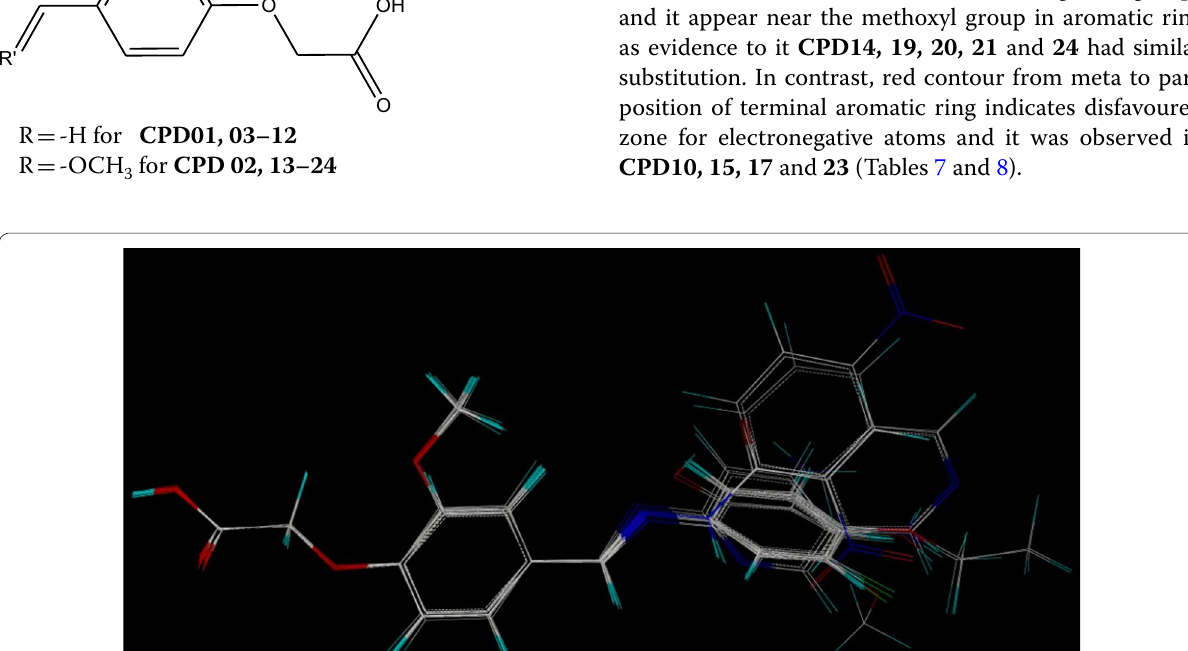
Fig. 8 Training set molecules after alignment by field fit